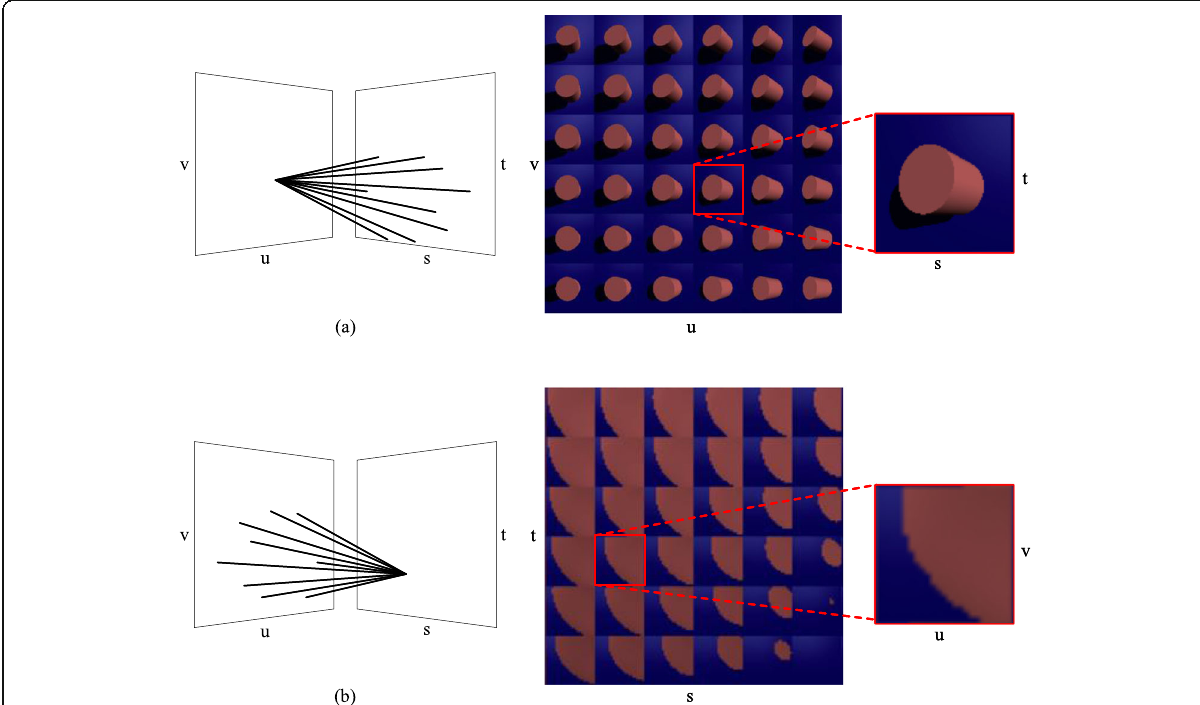
Fig. 2 Two visualizations of a light field. a Each image represents all the light rays leaving the st plane that can pass the same point on the uv plane; b Each image represents the light rays leaving from the same point on the st plane to different points on the uv